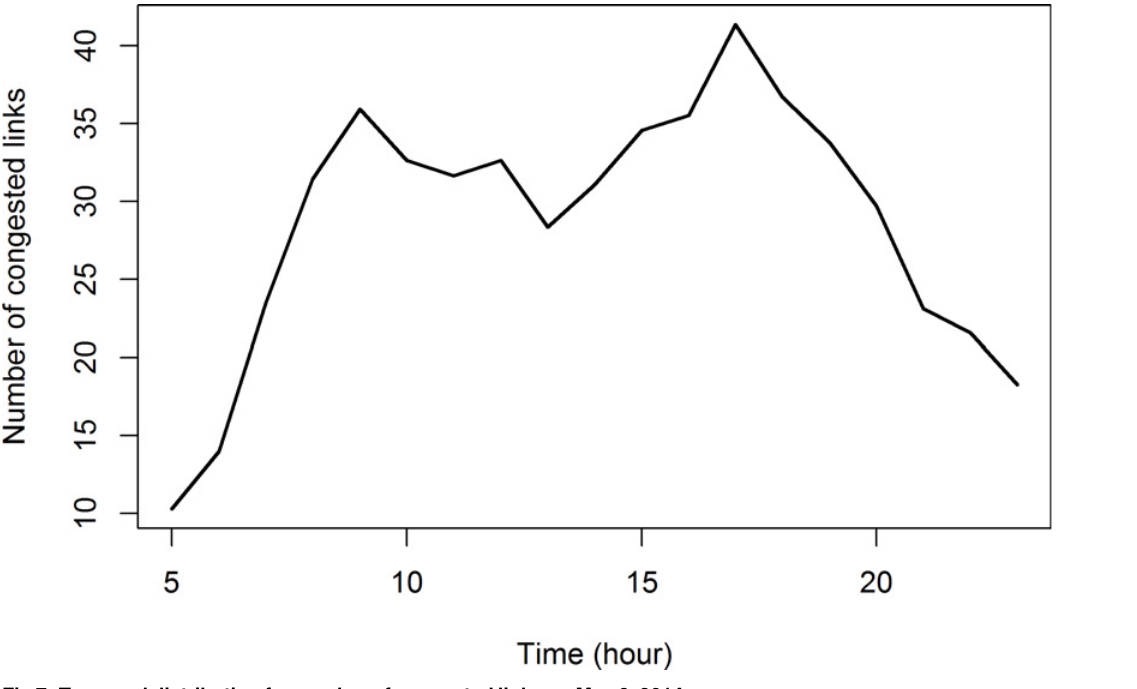
Fig 7. Temporal distribution for number of congested links on May 9, 2014.